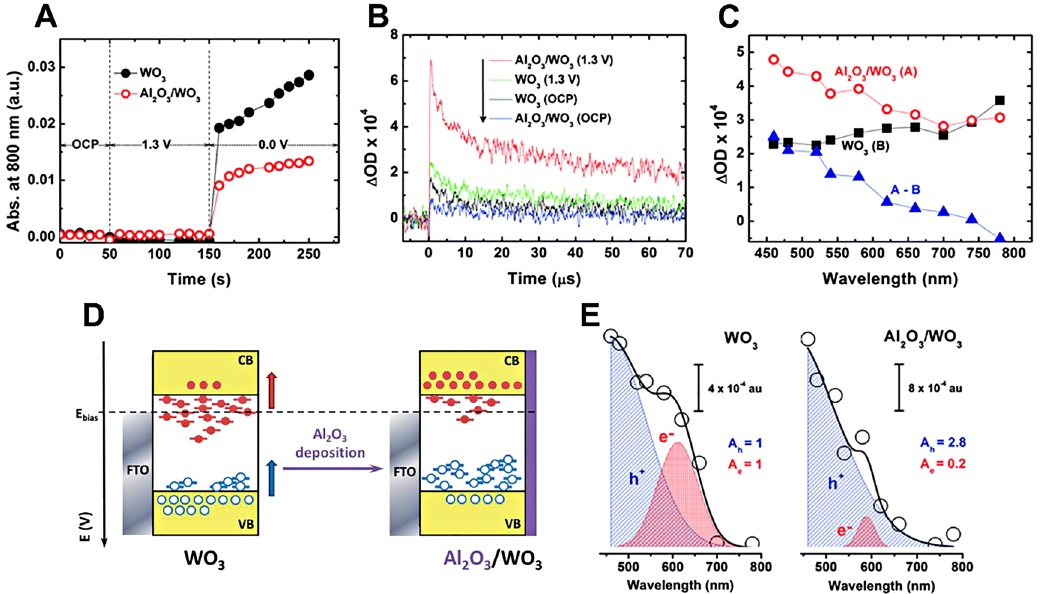
Figure 6: (A) Absorbance change at 800 nm for pure WO 3 and Al 2 O 3 /WO 3 at different applied biases in Ar-purged 0.1 M HClO 4 . (B) Transient absorption (TA) pro fi les of photoholes (480 nm) at open-circuit potential (OCP) and 1.3 V after UV excitation (355 nm, 250 μ J pulse − 1 ). (C) TA spectra of pure WO 3 and Al 2 O 3 /WO 3 at 1.3 V and 2 μ s after UV excitation. A, B represents the subtracted spectrum. (D)ProposedchargedynamicsmechanismofpureWO 3 andAl 2 O 3 /WO 3 underabiascondition.(E)DeconvolutedTAspectra of pureWO 3 and Al 2 O 3 /WO 3 at 1.3 V and 2 μ s after UV excitation. Reprinted with permission from a study by Kim et al. [44]. Copyright 2013 Royal Society of